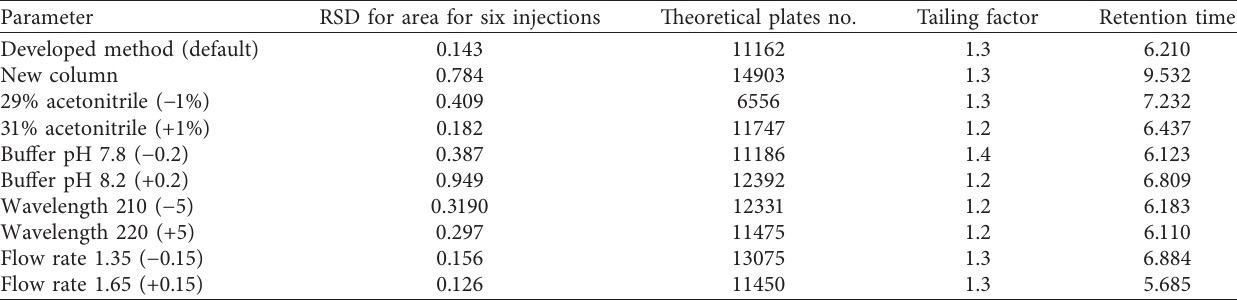
Table 4: Robustness of the developed method ( n � 6) (assay and statistical evaluation).